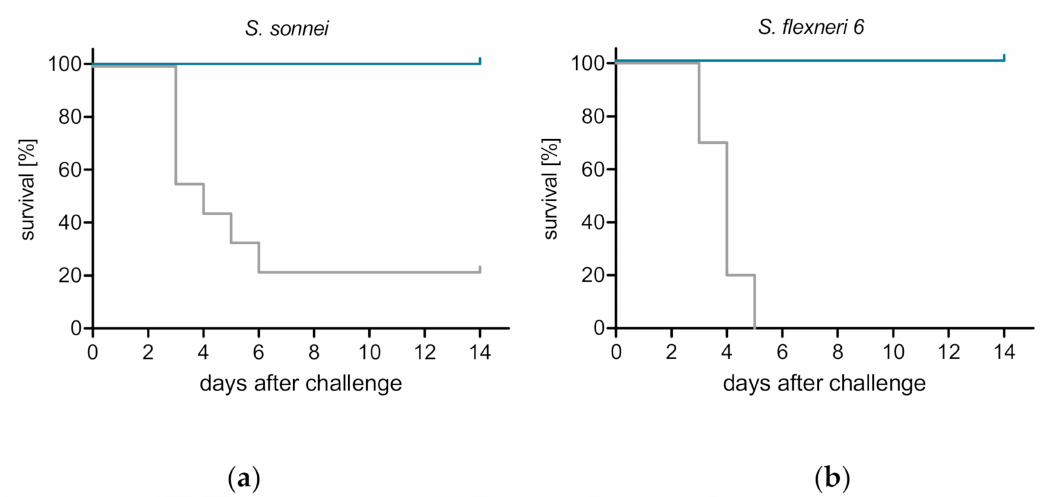
Figure 4. ShigETEC induces protection against lethal challenge with heterologous Shigella strains. Mice were vaccinated 3 times i.n. with 10 8 CFU ShigETEC (blue line) or bu ff er (grey line). Four weeks after the last vaccination, mice were challenged i.n. with lethal doses of ( a ) Shigella sonnei (9 × 10 6 CFU) or ( b ) Shigella flexneri 6 (1.2 × 10 7 CFU). Survival was monitored for 14 days. Data from two independent experiments with a total of 10 mice per group are